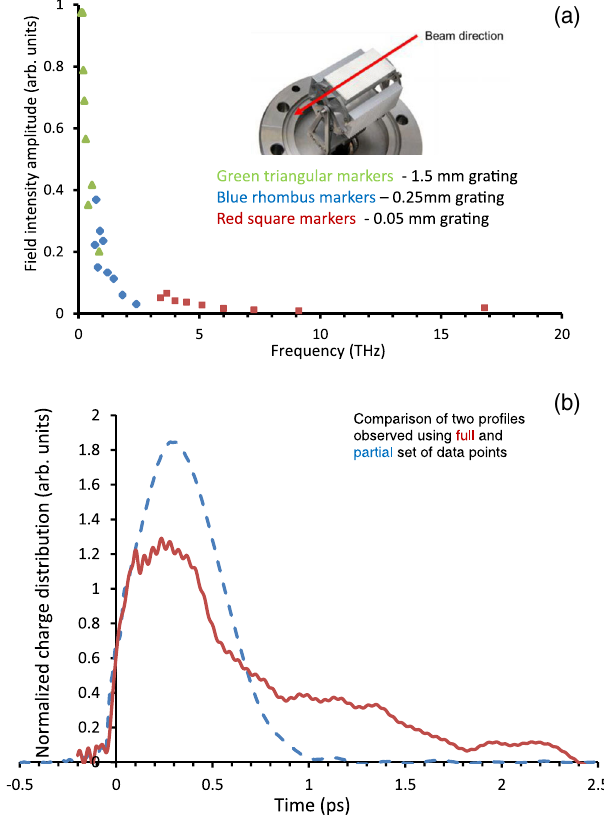
FIG. 3. The cSPr spectrum (a) and reconstructed bunch profile (b) observed using the average bunch profile cSPr monitor. The inset to (a) is the photograph of the four-target carousel used in the average bunch profile cSPr monitor with the red arrow showing the direction of electron beam propagation. In (a) the dots represent signal intensities at different sampling frequencies measured using the 1.5 mm grating (triangular marks), 0.25 mm grating (rhombus marks) and 0.05 mm grating (square marks). In (b) the profile shown by the dashed line was reconstructed by truncating all the data below 0.5 THz and substituting them with a Gaussian extrapolation while the profile shown by the solid line was obtained by using the full set of